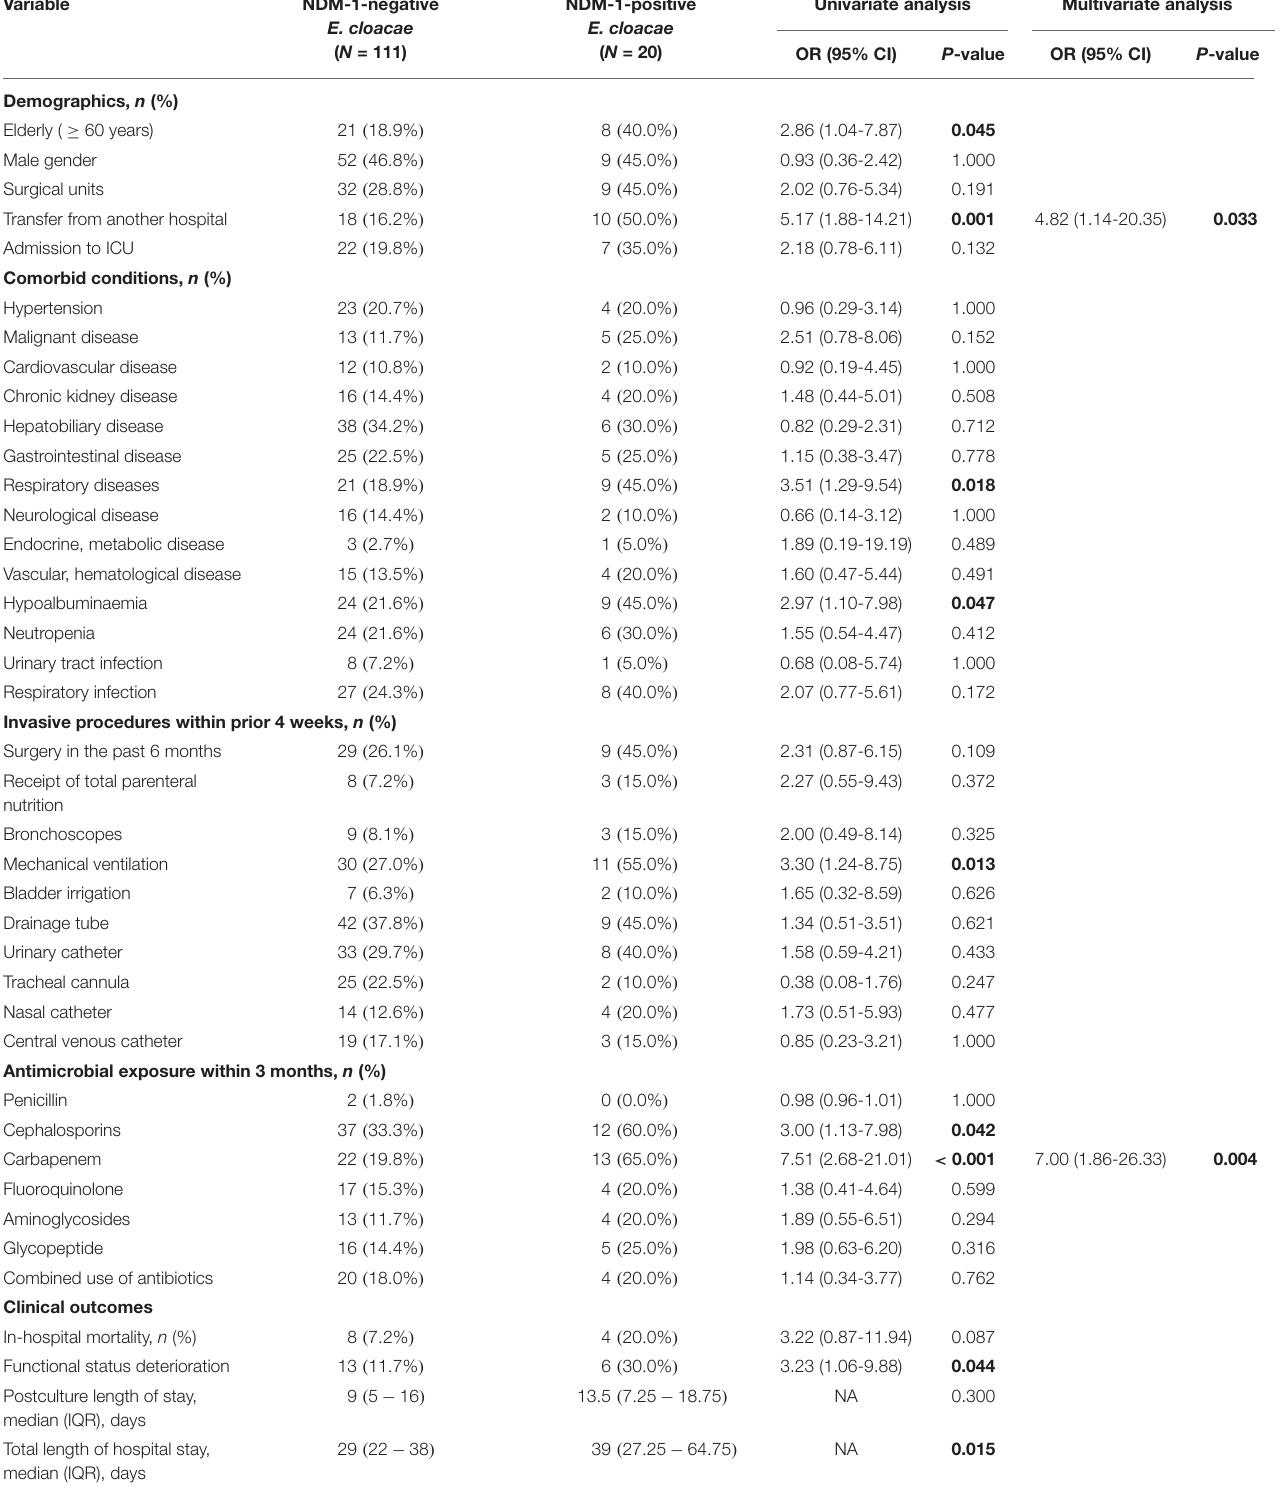
TABLE 4 | Univariable and multivariable analysis of risk factors and outcomes for isolation of NDM-1-positive CR-ECL isolates compared with negative controls.